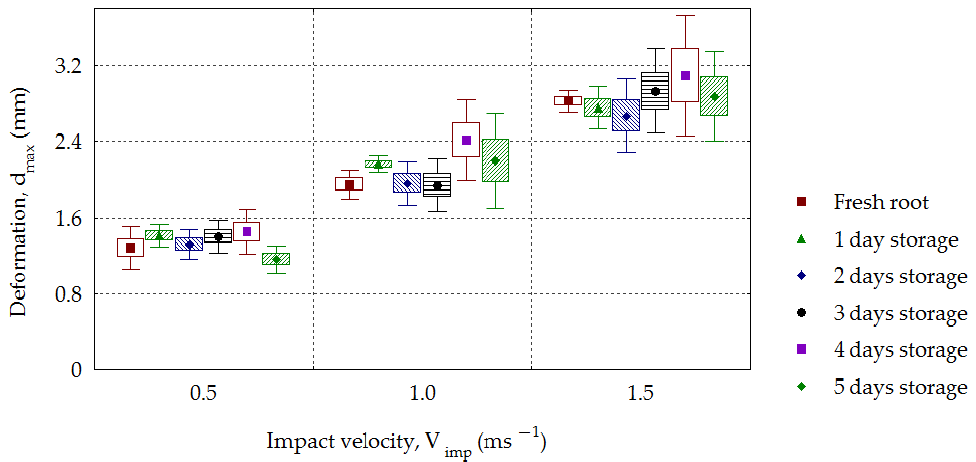
Figure 15. Dependence of the maximal impact stress ( σ imp ) on the impact velocity ( V imp ), taking the storage time ( S t ) into account.